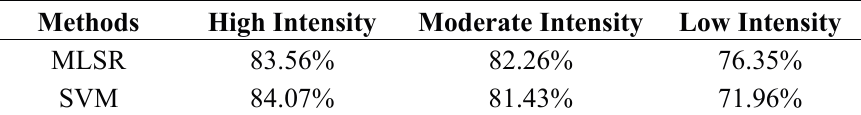
Table 3. Comparisons on intensities between MLSR and SVM.